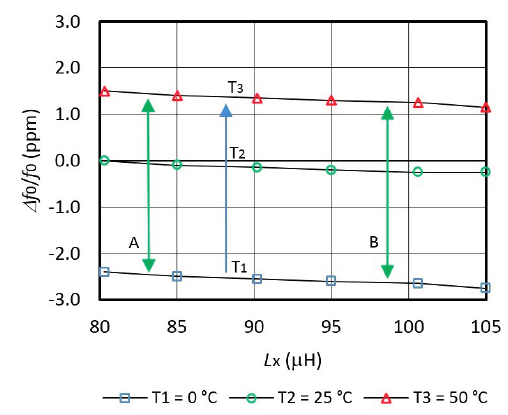
Figure 4. Non-compensated oscillator frequency Δ f 0 / f 0 characteristics variation depending on the temperatures T 1 , T 2 and T 3 and on L x ( C 10 = 8 pF).